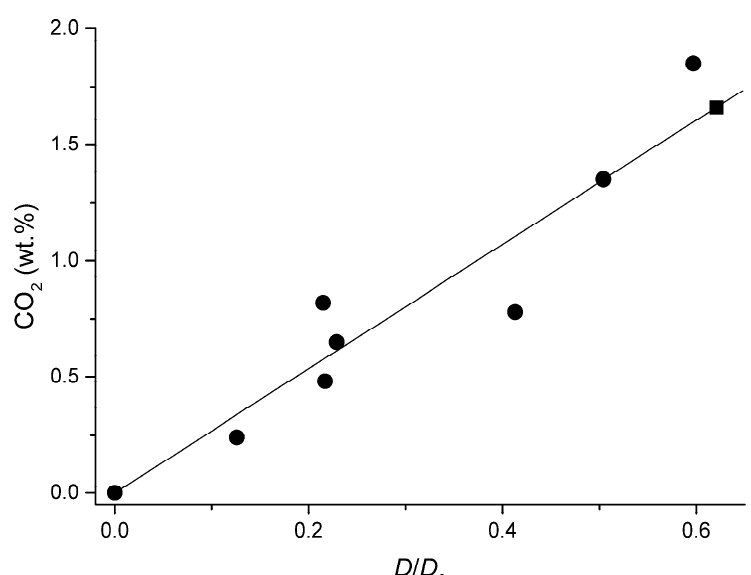
Figure 9. The correlation between the content of CO 2 determined by the selective sorption and relative optical density of the band at 2341–2346 cm − 1 ( D 0 is the optical density at the maximum of the band at 656–668 cm − 1 used as an internal standard). The circles correspond to Samples 1–8 and the square corresponds to Sample 9 with the CO 2 content determined using this correlation.